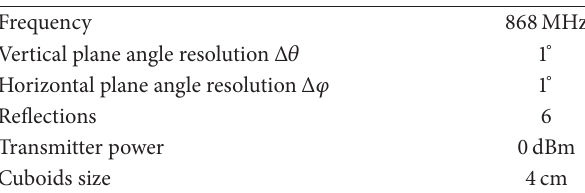
Table 2: Parameters in the ray launching